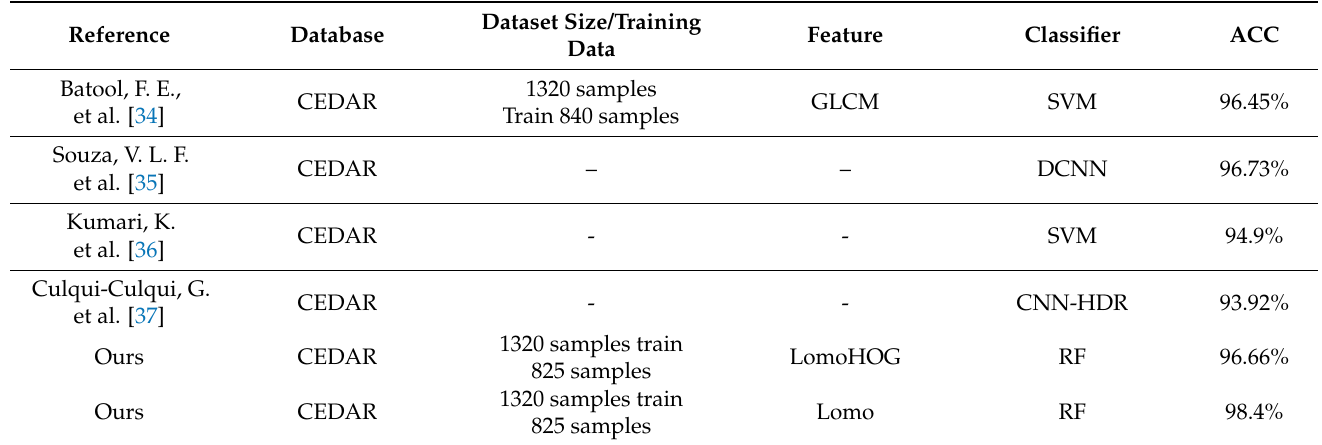
Table 11. Comparison of other research results on CEDAR